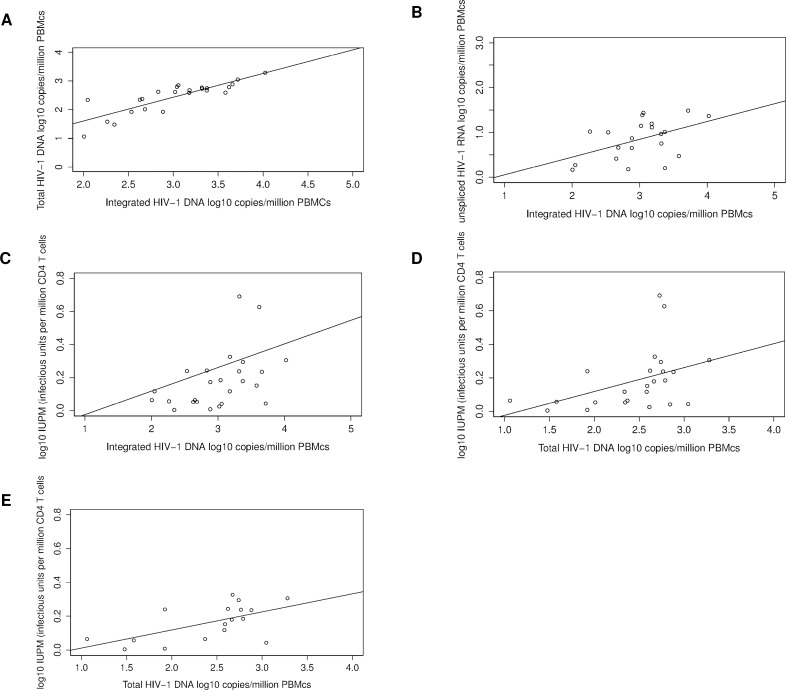
Linear regression analysis between viral reservoir markers.Associations between: A) Integrated HIV-1 DNA and total HIV-1 DNA; B) Integrated HIV-1 DNA and unspliced HIV-1 RNA; C) Integrated HIV-1 DNA and viral outgrowth assay; D) Total HIV-1 DNA and viral outgrowth assay; and E) Total HIV-1 DNA and viral outgrowth assay–outliers removed.